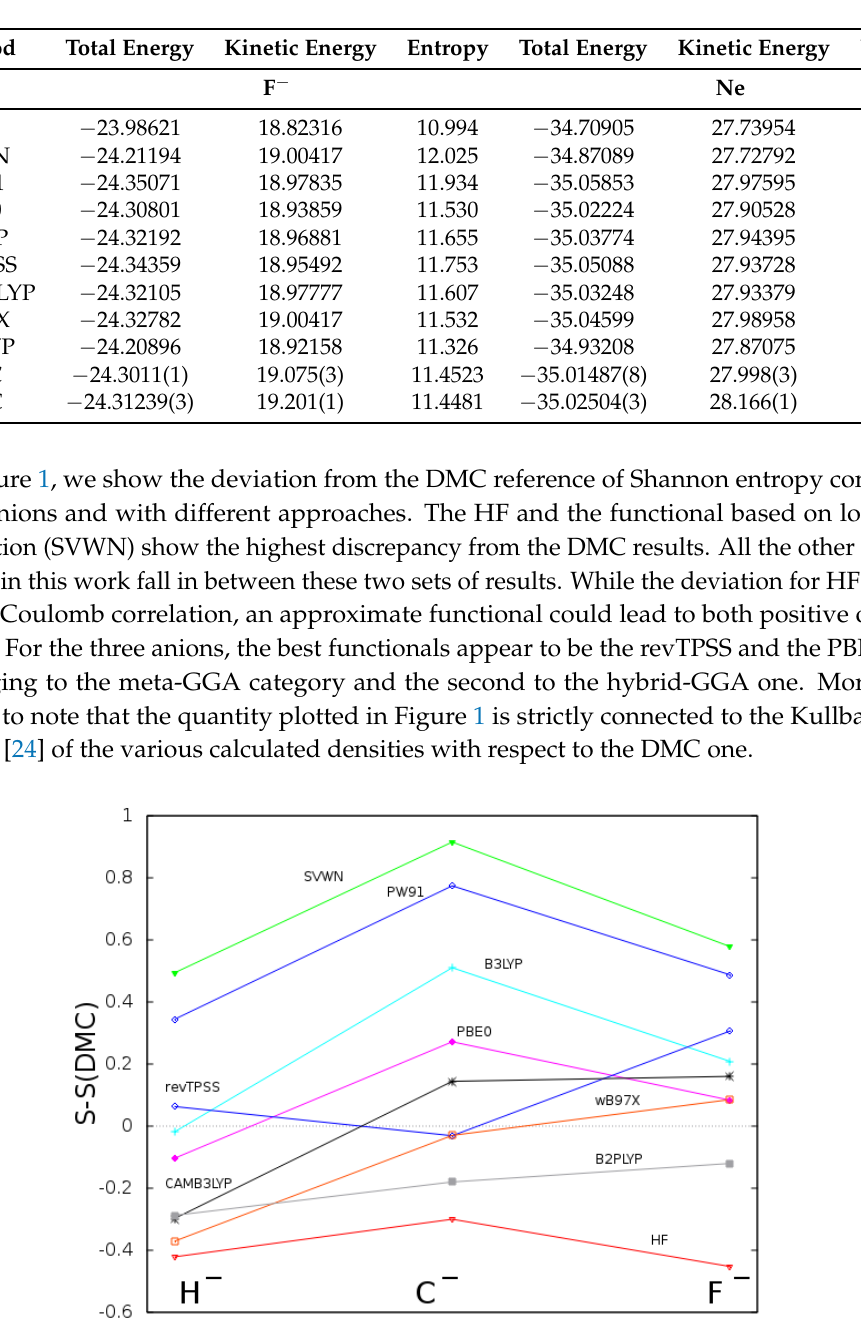
Table 3. Total energy, kinetic energy, and Shannon entropy for some atomic systems of the Ne-like series calculated at different level of computation. Data are in a.u.